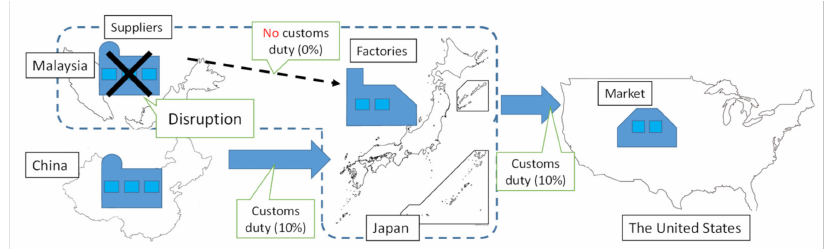
Figure 1. An example of a global supply chain, customs duty, and TPP. Map Source: https://www. freemap.jp/ (accessed on 30 November